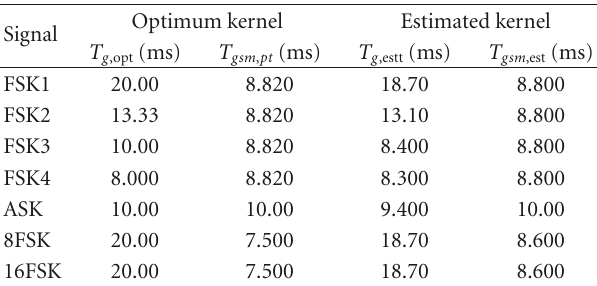
Table 3: Optimum and estimated kernel parameters.